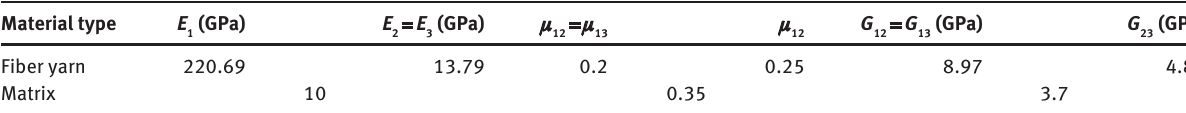
Table 1: Elastic constants for each component.